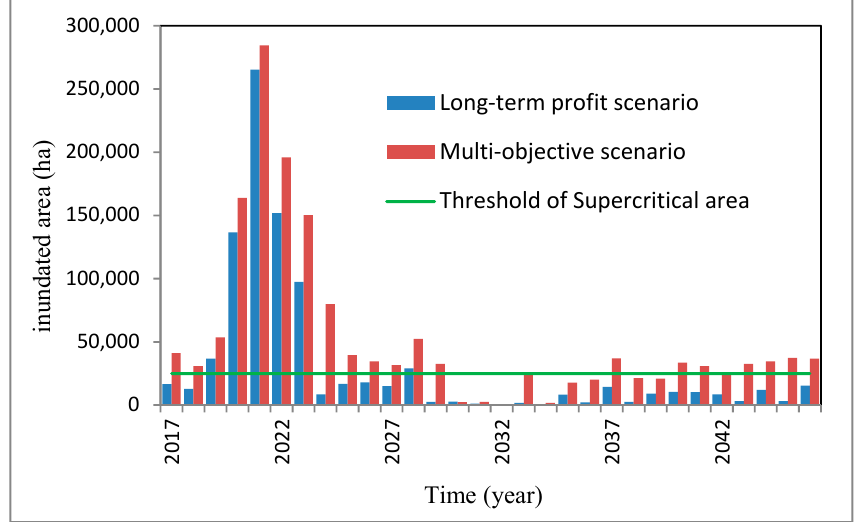
Figure 11. Average of wetland inundated between May and August.